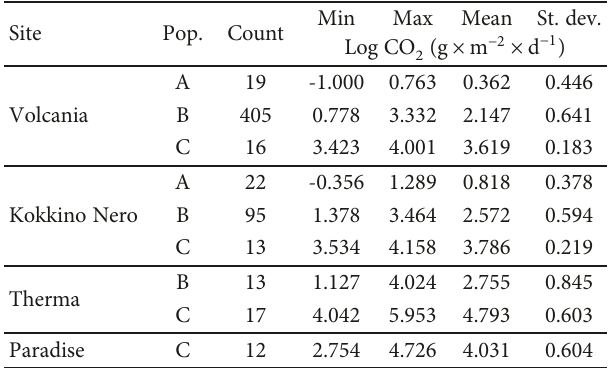
Min Max Mean St.